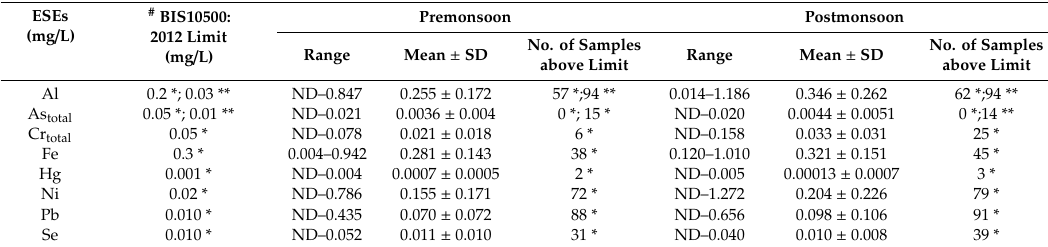
Table 1. Environmentally sensitive elements (ESEs) in groundwater during pre- and postmonsoon